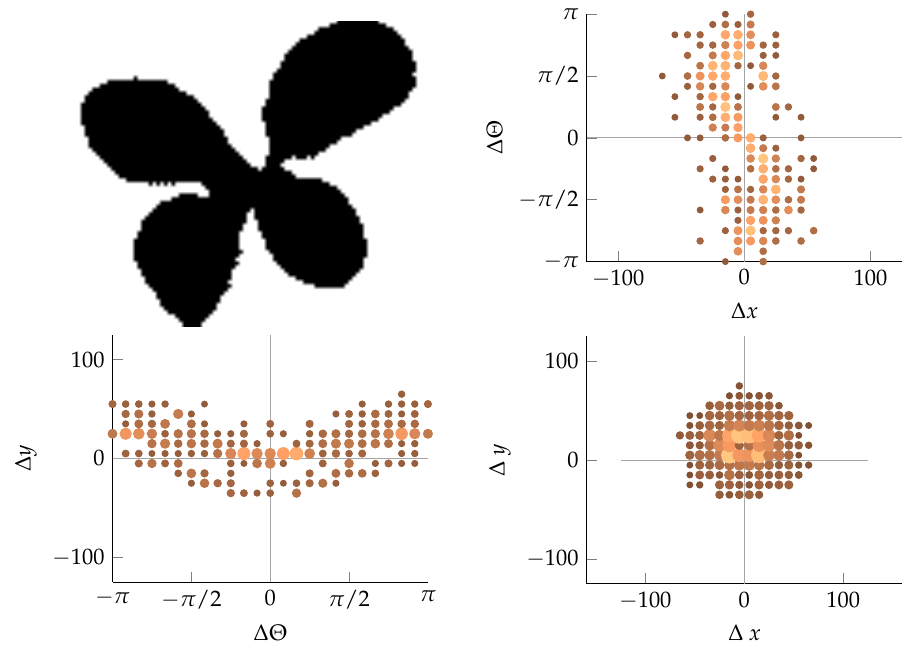
Figure 4. Dicots in 2D projections, which are similar to the representations in Figure